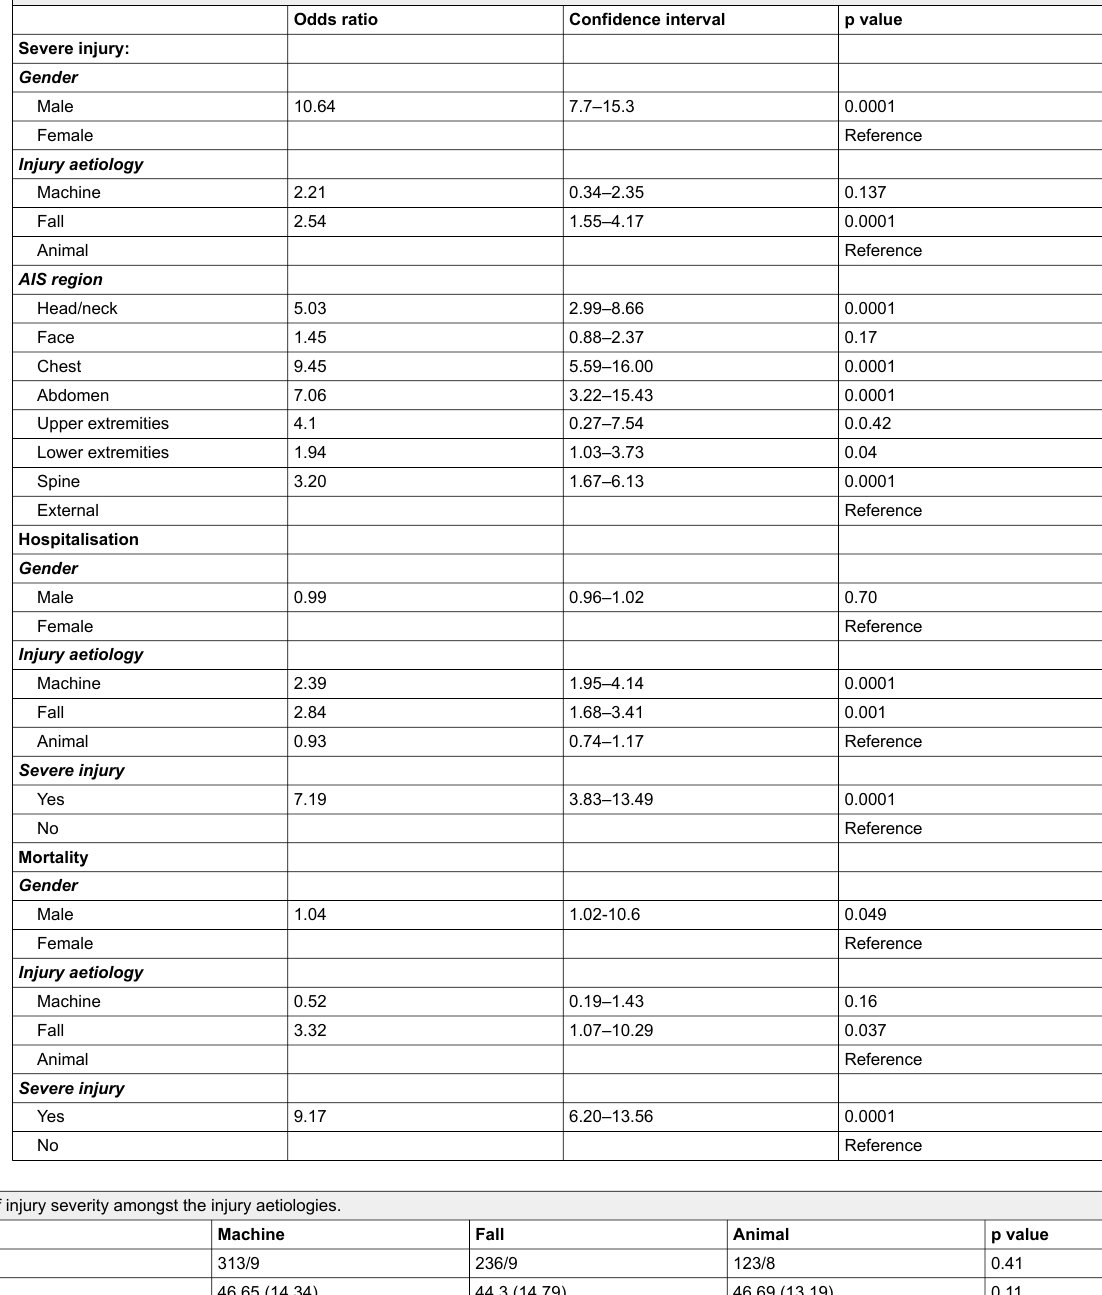
Table 2: Risk analysis.